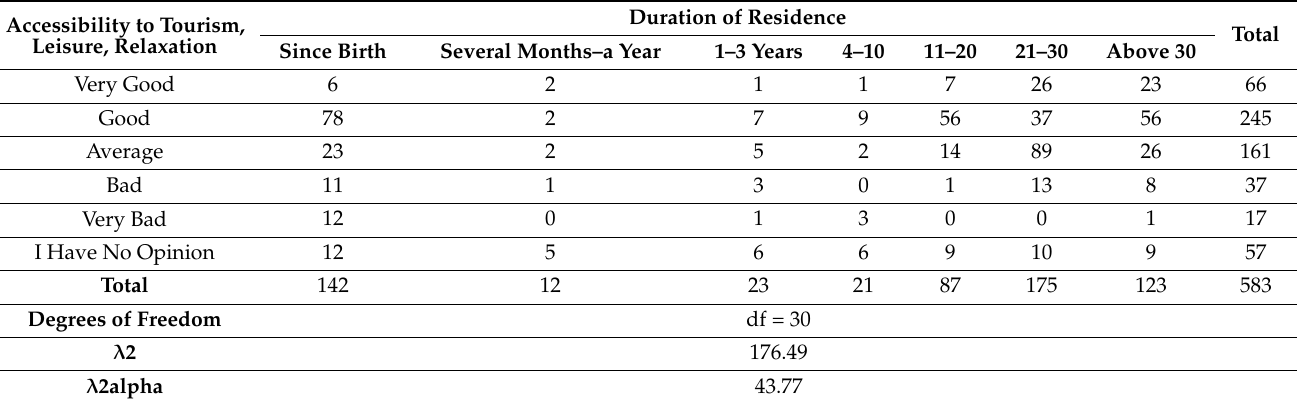
Table 7. Duration of residence and accessibility to tourism, leisure and